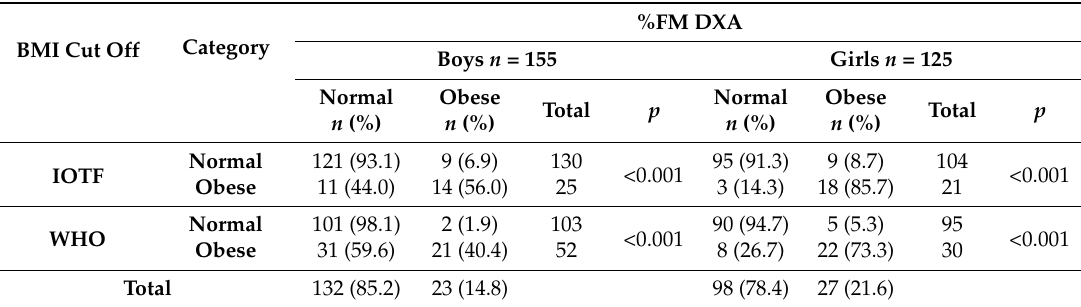
Table 2. Values of the prevalence of obesity in Chilean children and adolescents estimated by using the %FM determined by DXA and the Z-scores based on the IOTF and the WHO